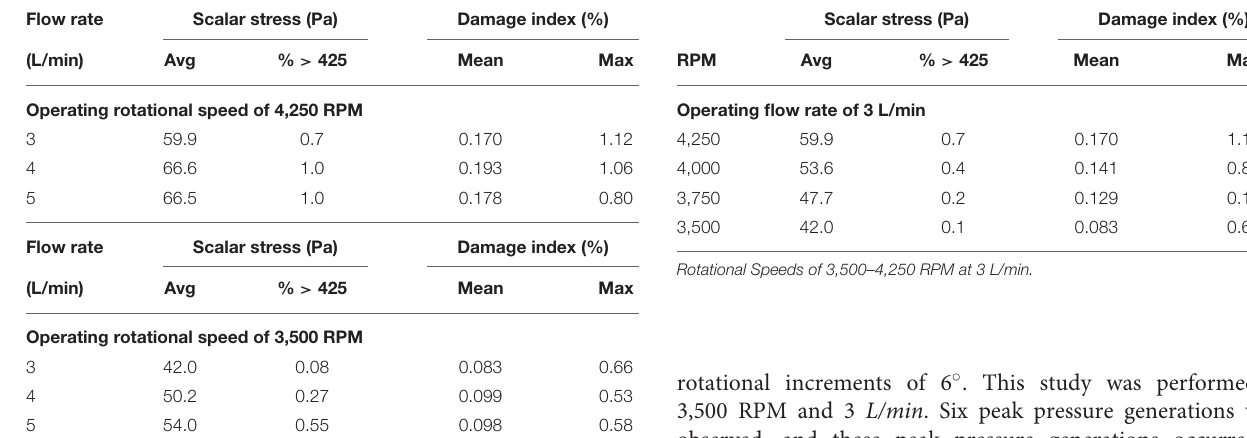
TABLE 2 | Fluid stress level and blood damage index estimations for the centrifugal pump